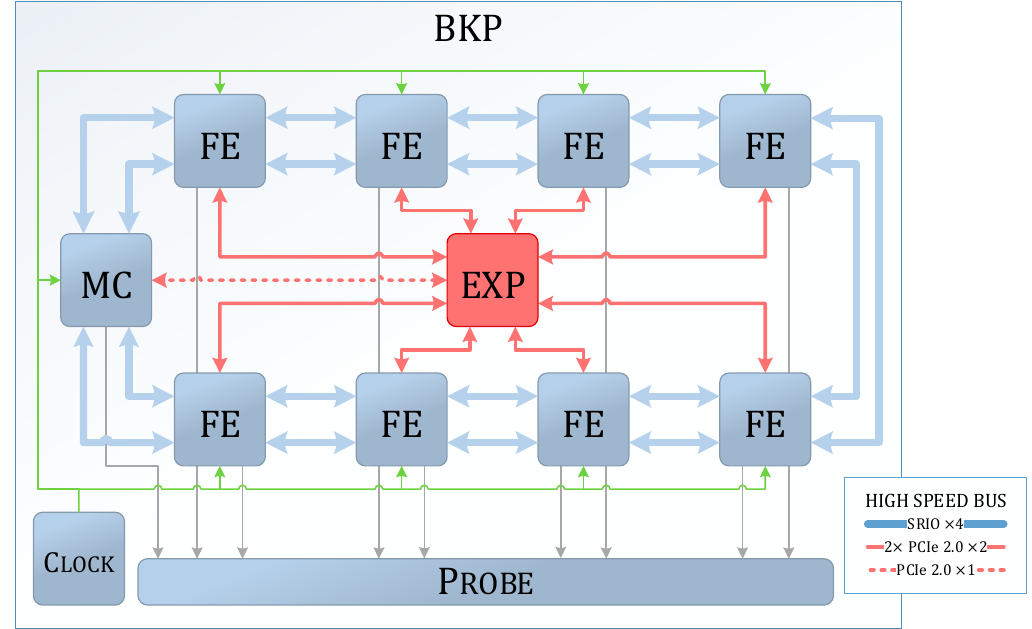
Figure 2. The modified Back-Plane architecture of ULA-OP 256. The new EXP board and related connections are highlighted in red. The Master Control (MC) and the Front End (FE) boards are also connected to the ultrasound probe.